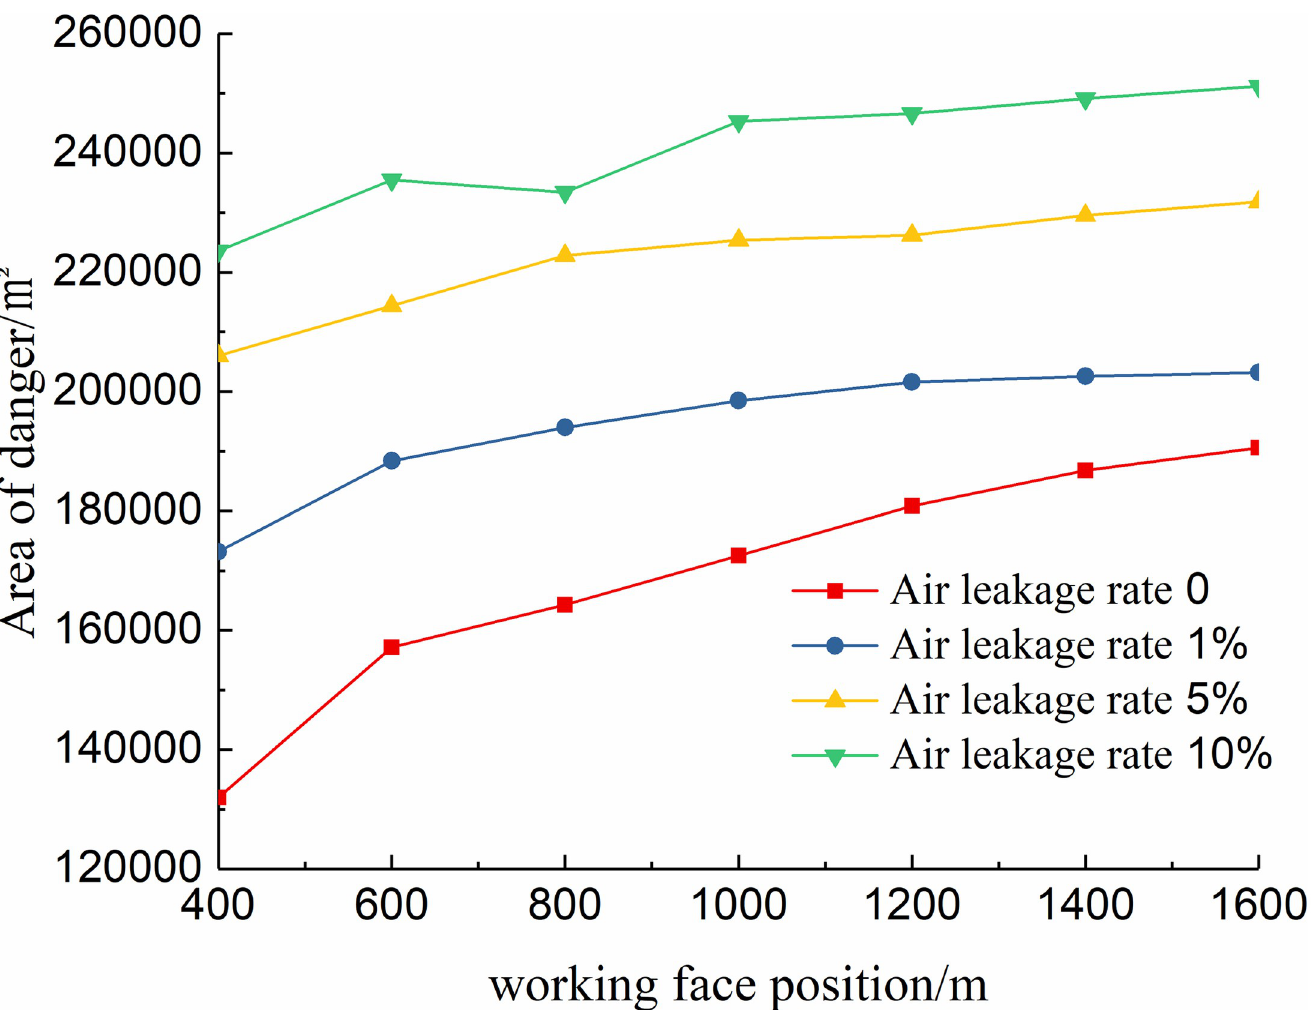
Fig 11. Change curve of the spontaneous combustion danger area under different positions of the working